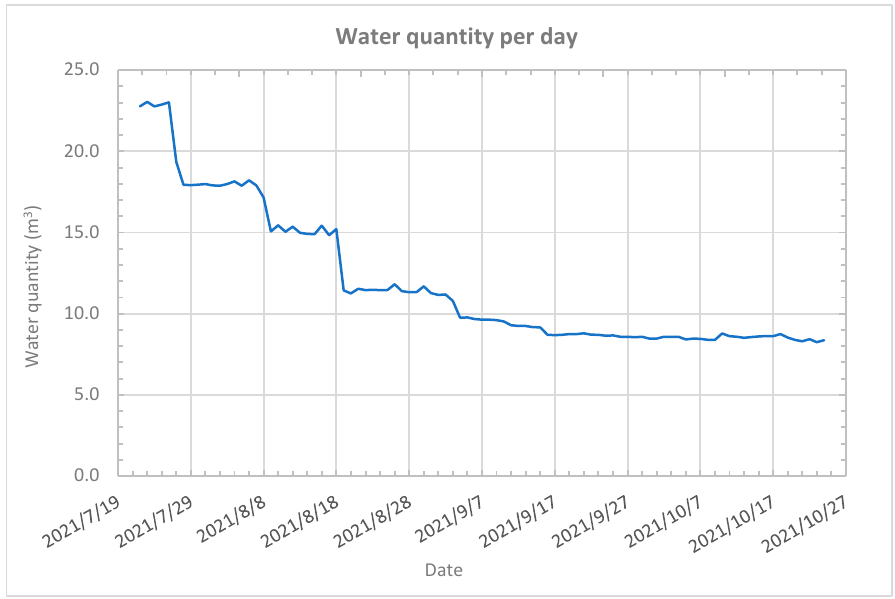
Figure 11. Water quantity monitoring.